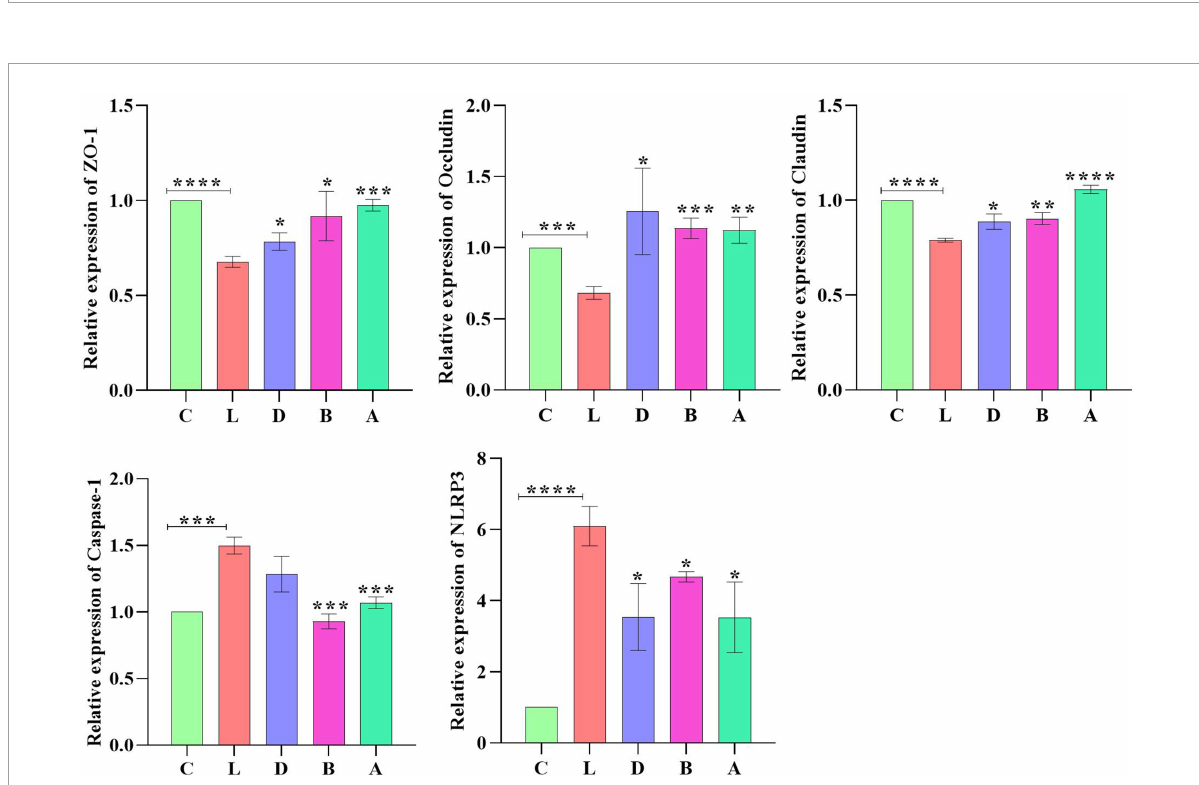
FIGURE12 Relative expression analysis of ZO-1, Occludin, Claudin, Caspase-1, and NLRP3 via qRT-PCR. Significance is presented as * p < 0.05, ** p < 0.01, *** p < 0.001, and **** p < 0.0001; data are presented as the mean ± SEM ( n =